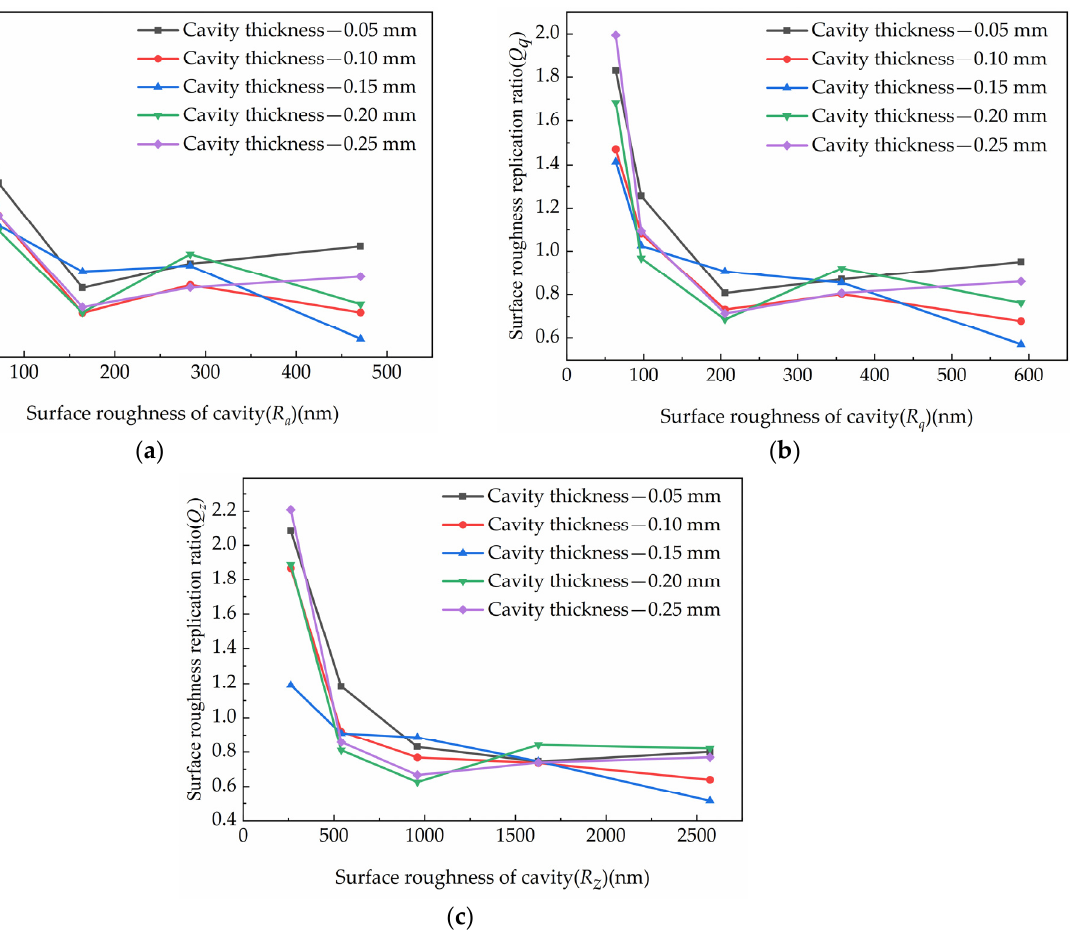
Figure 10. The replication ratio of each roughness parameter under different cavity thickness: ( a ) Q a , ( b ) Q q ( c ) Q z.